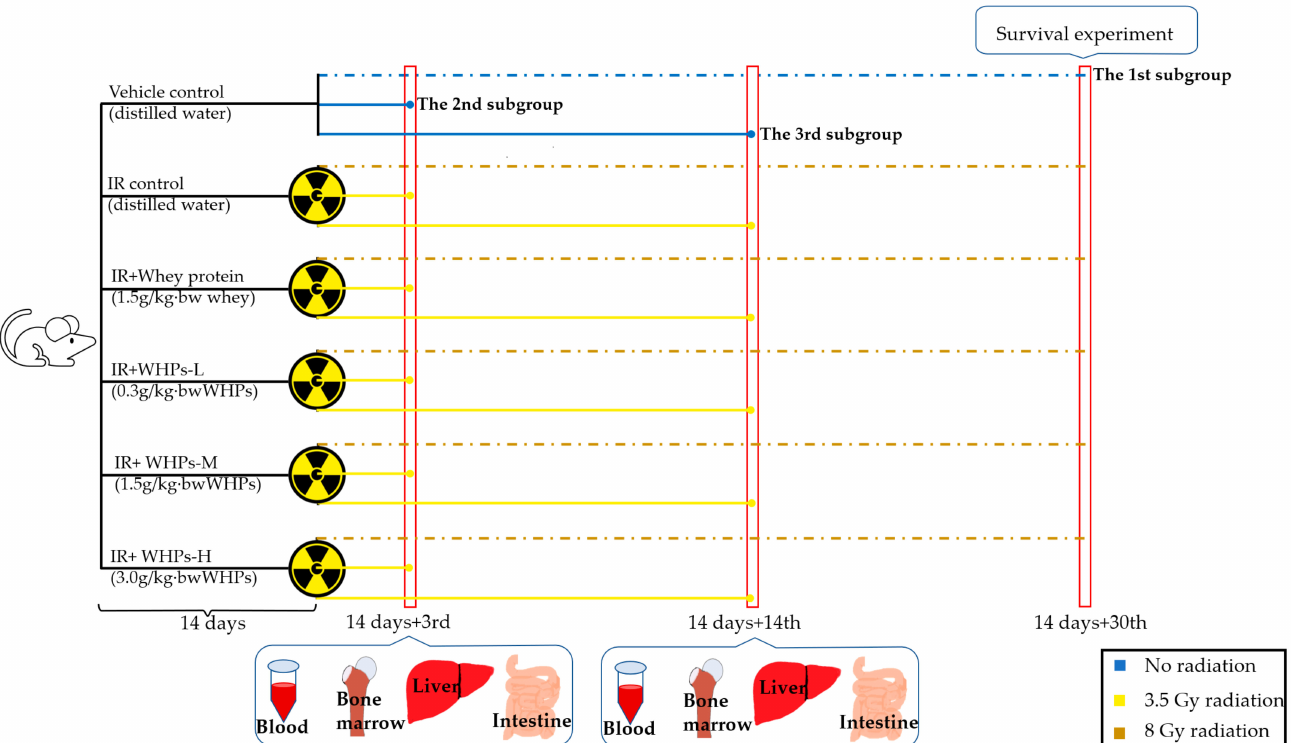
Figure 1. Study process diagram. IR, irradiated mice; IR+WHPs-L, irradiated mice+low-dose whey hydrolysate peptides; IR+WHPs-M, irradiated mice+medium-dose whey hydrolysate peptides; IR+WHPs-H, irradiated mice+high-dose whey hydrolysate